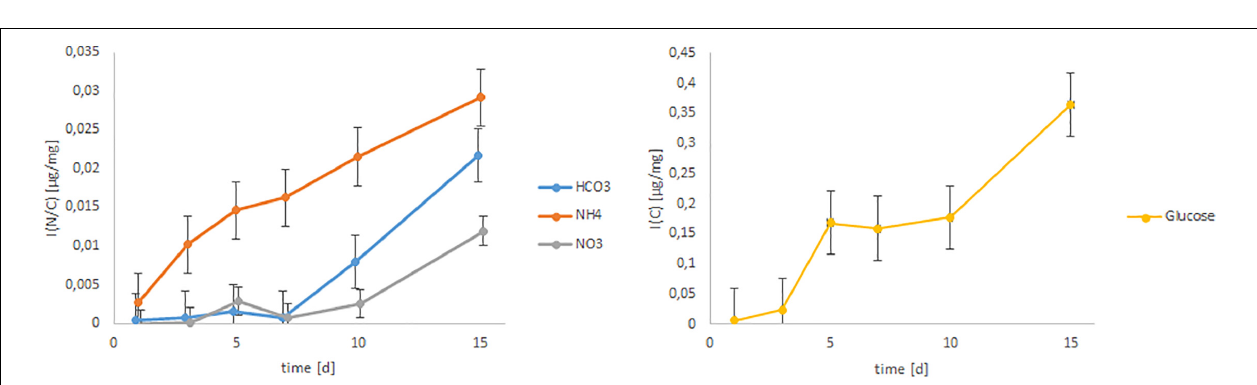
FIGURE 3 | C and N uptake of dried and fresh algal food sources by C. selseyense . The letters on x-axis are representing: C, Chaetoceros calcitrans ; D, Dunaliella tertiolecta ; I, Isochrysis galbana ; L, Leyanella arenaria ; N, Nannochloropsis salina ; P, Phaeodactylum tricornutum . The datapoints were calculated from n = 3 replicates and the error bars indicate the standard deviation. The box plots (A,C) represent the uptake of C and N after 1 day, (B,D) show the uptake after 3 days.